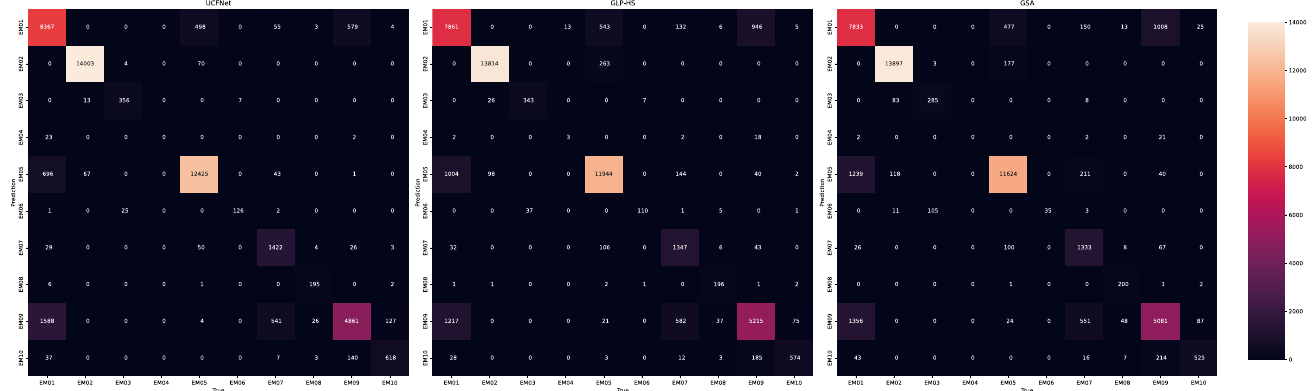
Figure 8. Confusion matrix of the linear SVM classifier. Left is the sharpened image of our method, middle is the sharpened image of GLP-HS, and right is the sharpened image of